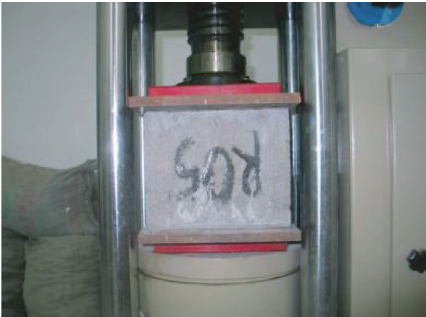
Figure 3: Compression test.